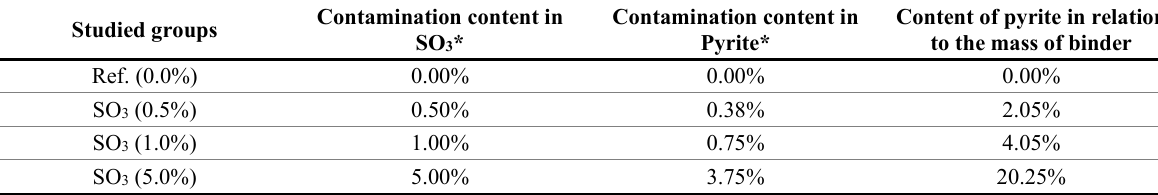
Table 2. Proportional contamination levels.